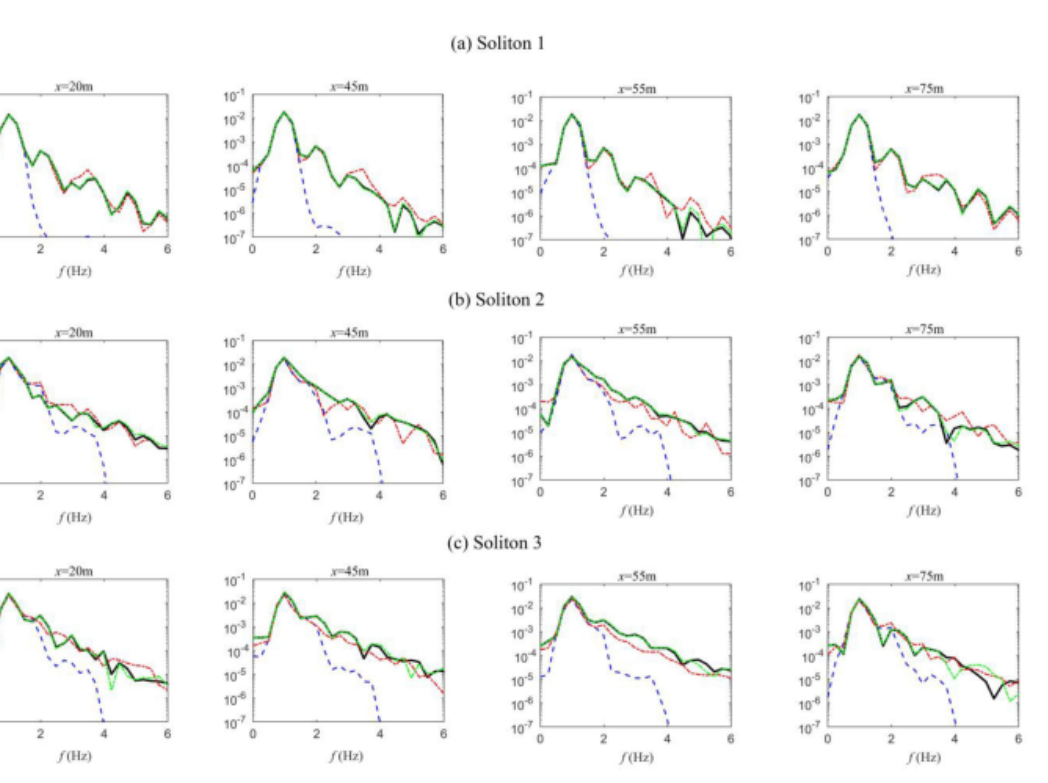
Figure 11. The wave amplitude spectra at different locations along the flume for ( a ) Soliton 1, ( b ) Soliton 2, and ( c ) Soliton 3. The blue dashed lines correspond to the simulation with only linear effects ( M = 1). The red dashed dot lines correspond to the simulation with second harmonic effects ( M = 2). The green dashed dot lines correspond to the simulation with third-order nonlinear effects ( M = 3). The black solid lines correspond to almost fully nonlinear simulations ( M =